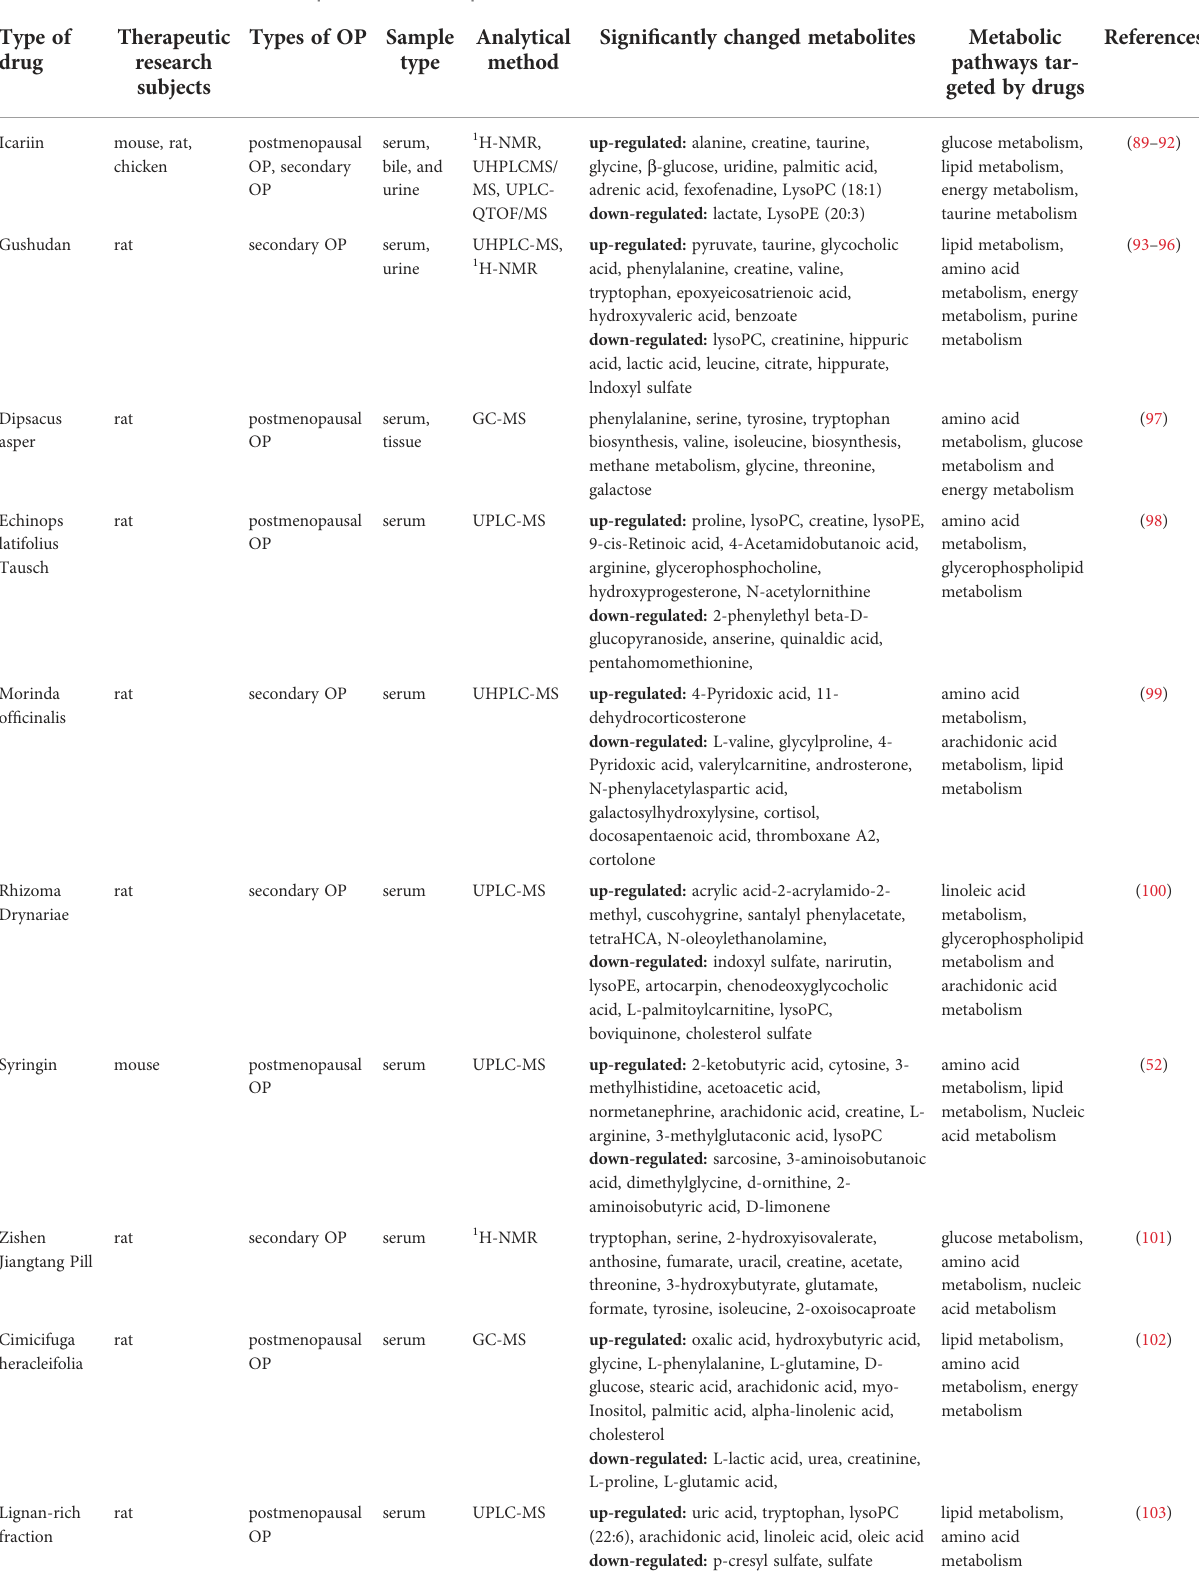
TABLE 3 Metabolomics for the development of OP